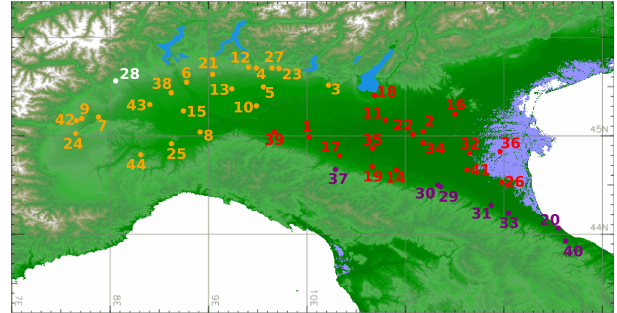
Figure 1. Location of PM 2 . 5 monitoring stations included in the analysis. The key for ID number is found in Table 1. Colour coding refers to the result of the cluster analysis performed using a divi- sive algorithm: sites within the same cluster have the same colour. Site 28 (Biella) resulted in an outlier and was not included in this classification. Results of the cluster analysis with partition around medoids algorithm are in Fig. S3. More details are in Sects. 2.3 and